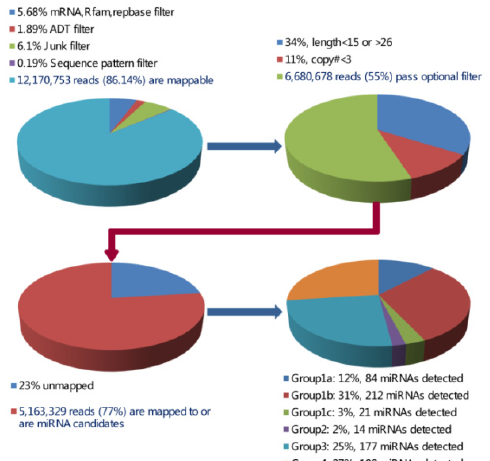
Figure 1. The chart of sequencing data analysis through various filters and the number of miRNAs